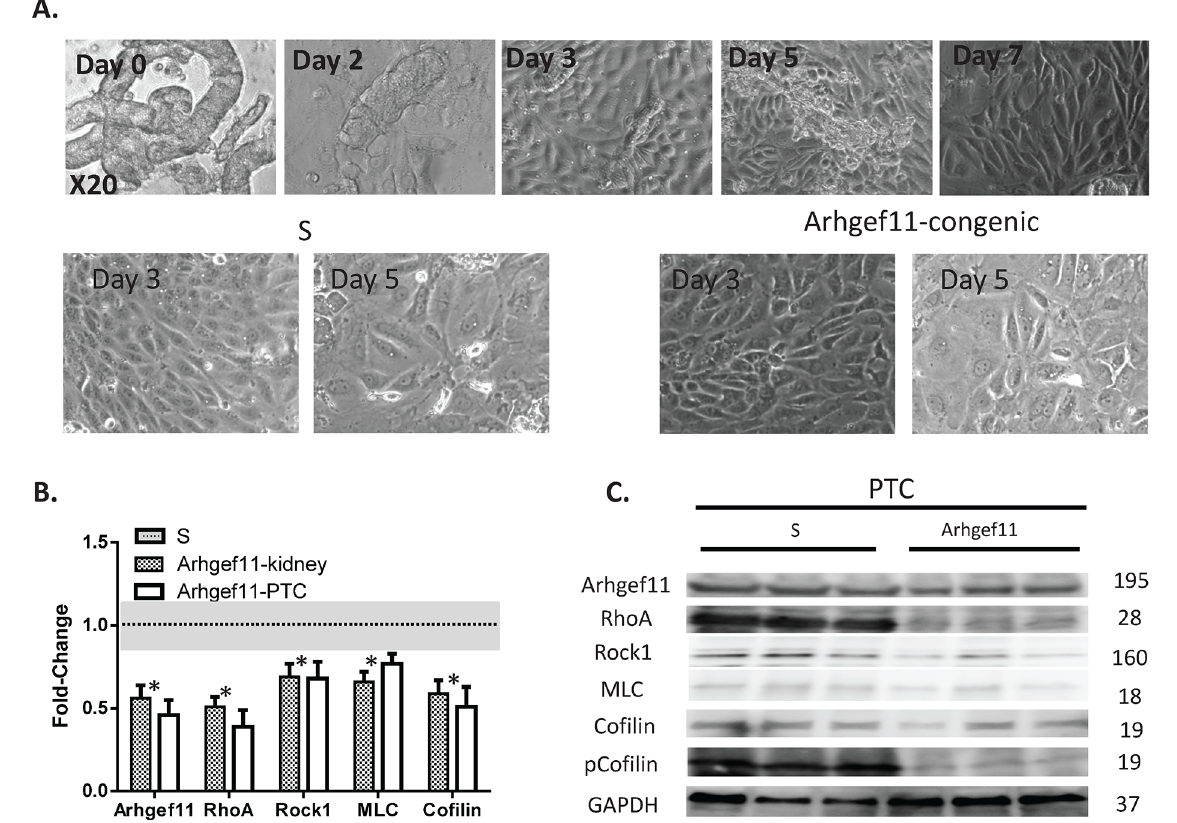
Fig 6. Primary proximal tubule cell (PTC) culture and Arhgef11-Rho-ROCK signaling pathway. ( A ) Representative phase-contrast images (at 20X) of isolated tubular fragments (Day 0) and outgrowth and culture of proximal tubules cells (Day 2 – 7). There appears no obvious morphological difference between PTC derived S and Arhgef11-congenic. ( B ) Real-time PCR of Arhgef11-Rho-ROCK signaling genes from kidney tissue and PTC acquired from S and Arhgef11-congenic at 4 – 6 weeks of age. Cultured PTCs (Day 5) exhibit a similar down-regulation of Arhgef11 and signaling pathway as kidney tissue. ( C ) Western analysis of Rho-Rock pathway in cultured PTC. n = 4 – 6 independent samples, * p < 0.05 versus S, Error bar are ± SD.